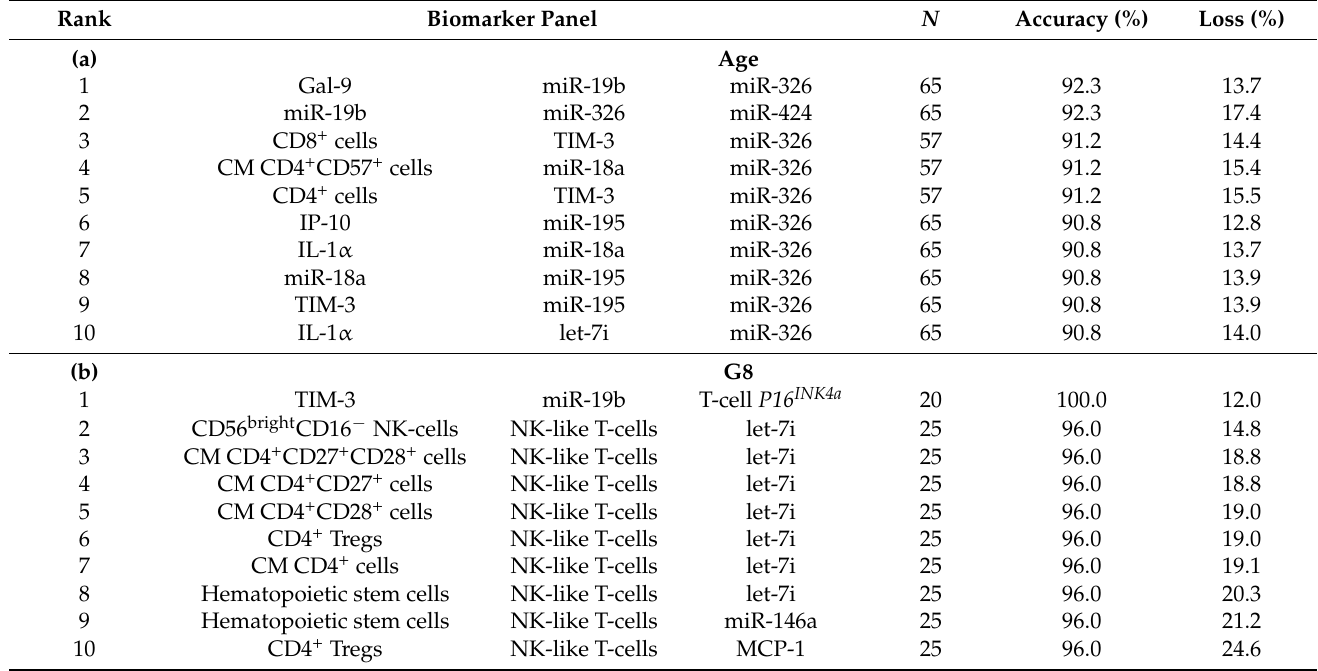
Table 2. Based on their performance (i.e., accuracy and loss), the biomarker panels were assigned a rank. The 10 highest ranked (i.e., highest accuracy and lowest loss) biomarker panels to classify patients in (a) the age groups: younger age group (35–45/55–65 years) or the older age group ( ≥ 70 years), and (b) the frailty groups: fitter group of older patients (G8 > 14) or the frailer group of older patients (G8 ≤ 14) are shown. The number of patients ( N ) for whom a specific panel could be assessed, as well as the panels’ accuracies and losses are